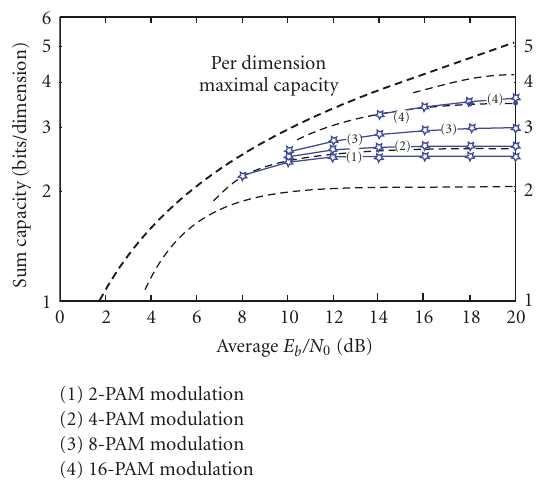
Figure 6: Achievable spectral e ffi ciencies for three MIMO termi- nals with relative power di ff erences of 0dB, − 6 dB, and − 9dB via simulations, plotted against the average bit energy-to-noise-power